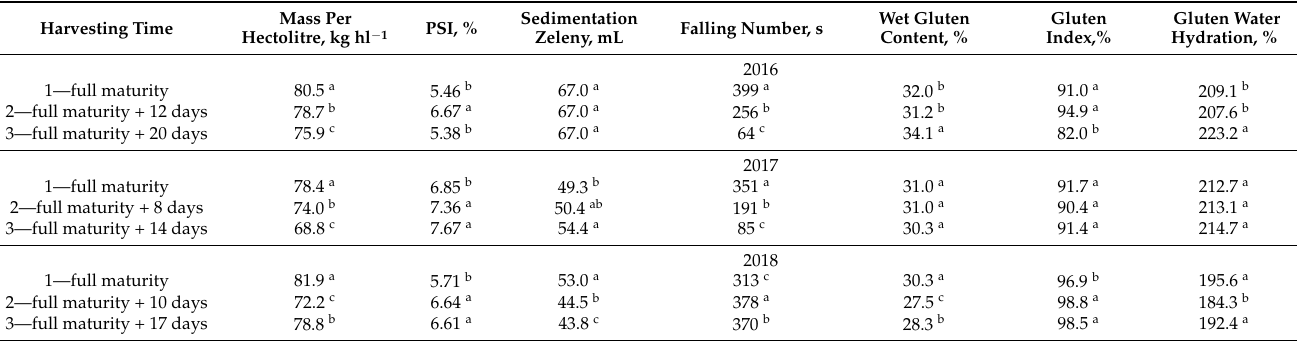
Table 4. The quality of spring grain in